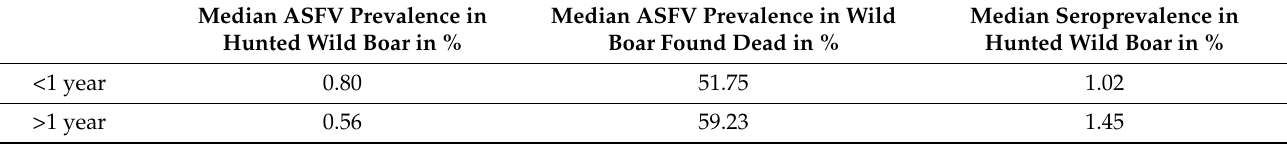
Table 1. Median yearly African swine fever virus and seroprevalence estimates in Lithuanian wild boar from 2016–April 2021 for each age class.